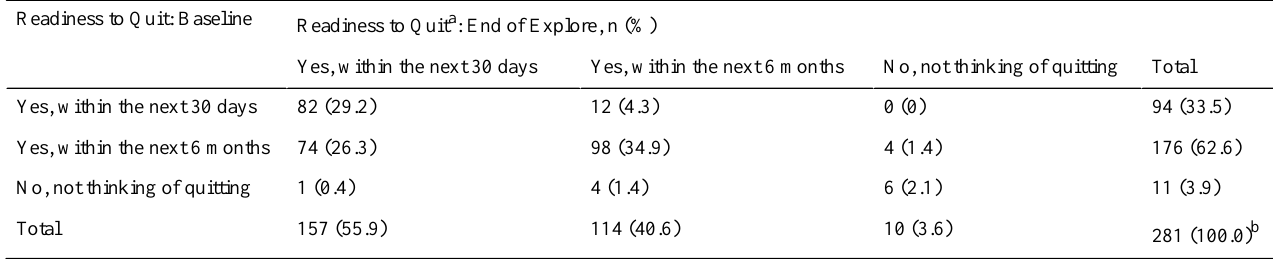
Readiness to Quit a : End of Explore, n (%)Readiness to Quit: Baseline